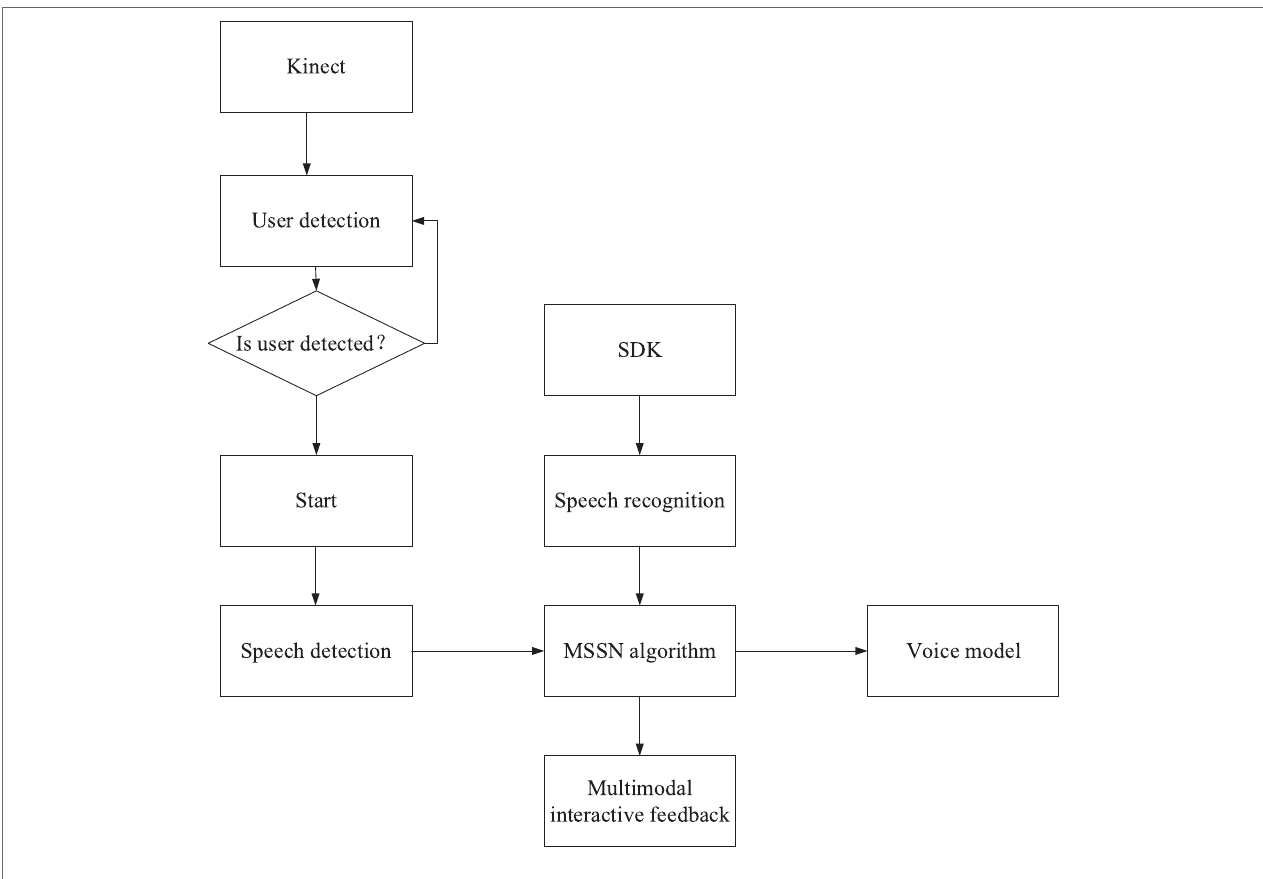
FIGURE 2 | System